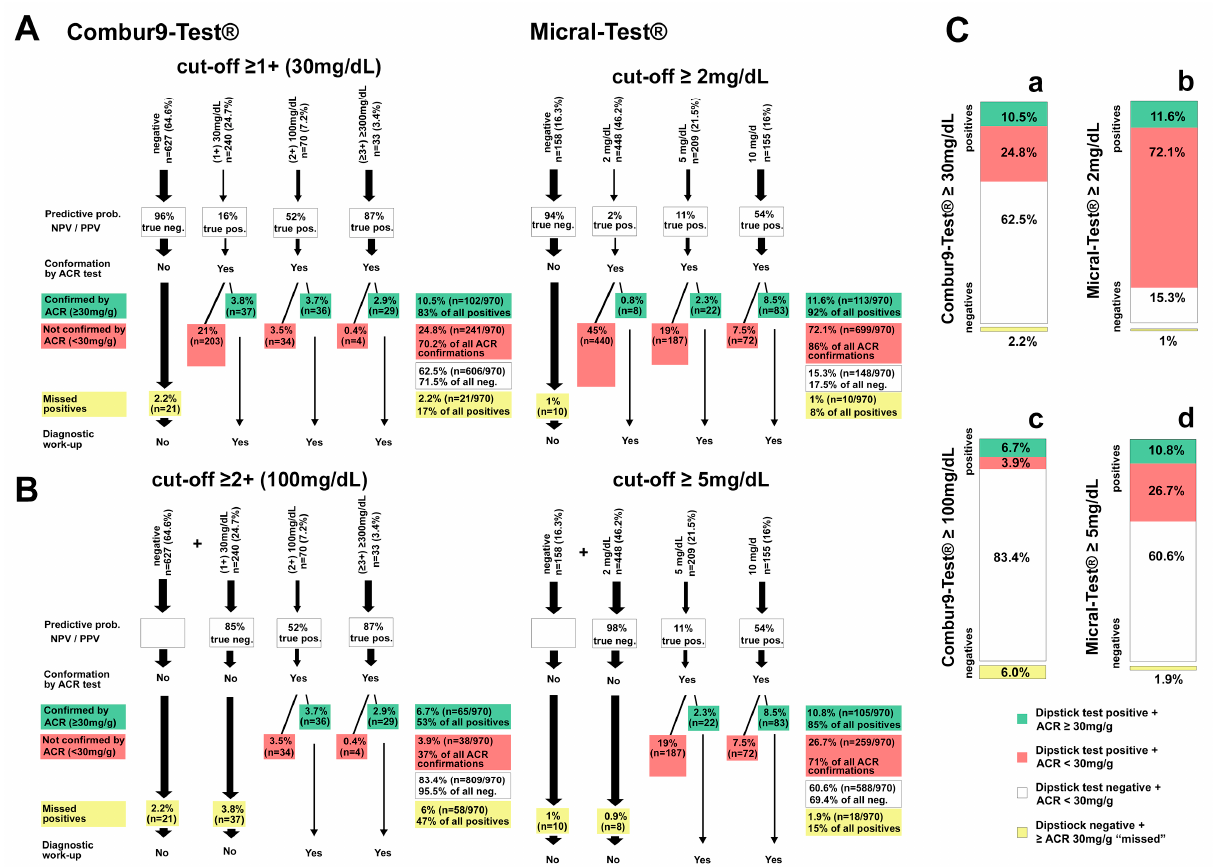
Figure 5. Models for albuminuria screening algorithms with Combur9-Test ® and Micral-Test ® in 970 patients (reference test: albumin-to-creatinine ratio (ACR) with a cut-off of ≥ 30 mg/g): ( A ) cut-off for negative index tests: Combur9-Test ® cut-off ≥ 1+ ( ≥ 30 mg/dL) and Micral-Test ® cut-off ≥ 2 mg/dL; NPV all negative Combur9-Test ® and Micral-Test ® ; ( B ) cut-off for negative index tests: Combur9-Test ® cut-off ≥ 2+ ( ≥ 100 mg/dL) and Micral-Test ® cut-off ≥ 5 mg/dL; NPV all patients ≤ 1+ Combur9-Test ® , all patients ≤ 5 mg/dL Micral-Test ® ; true neg: true negatives with index test and confirmation test negative; true pos: true positives with index test and confirmation test positive; PPV: positive predictive value; ( C ) Distribution of correctly confirmed Combur9-Test ® and Micral-Test ® by an ACR at a cut-off of 30 mg/g; (a) Combur9-Test ® cut-off ≥ 1+ ( ≥ 30 mg/dL) (b) Micral-Test ® cut-off ≥ 2 mg/dL, (c) Combur9-Test ® cut-off ≥ 2+ ( ≥ 100 mg/dL) (d) Micral-Test ® cut-off ≥ 5 mg/dL for positivity; NPV: negative predictive value; ACR: albumin-to-creatinine